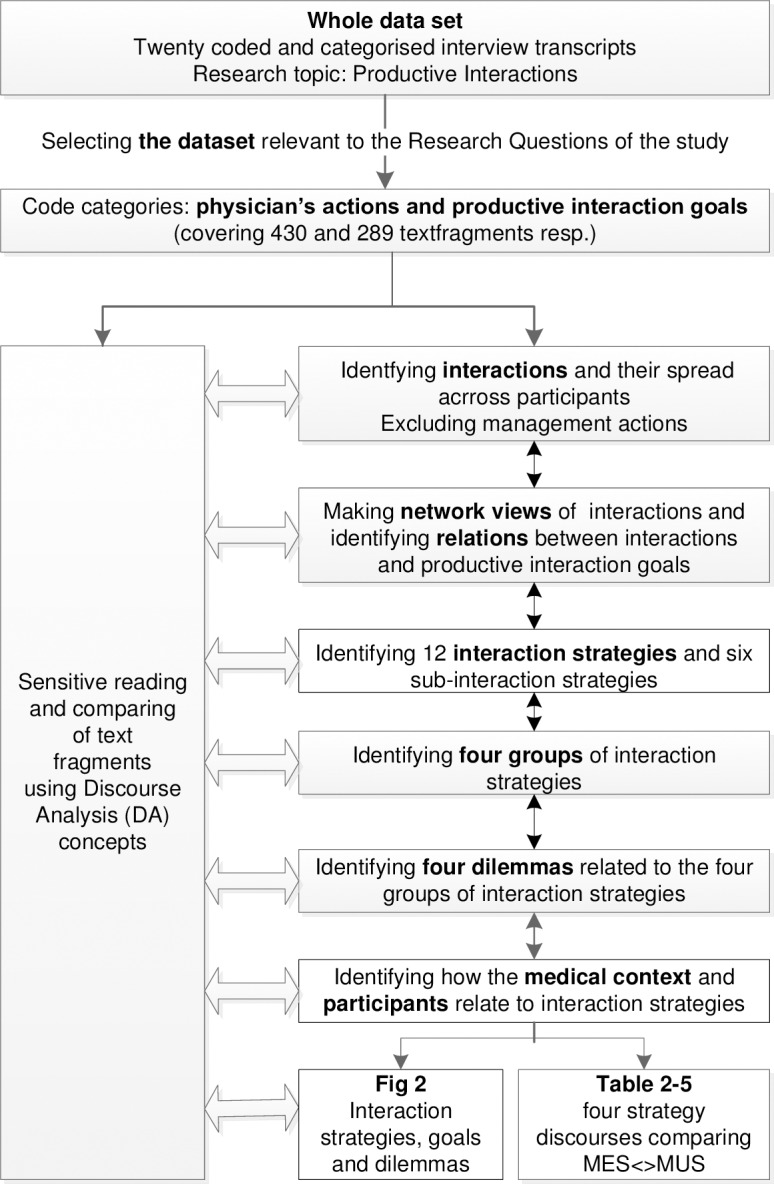
Analysis process.